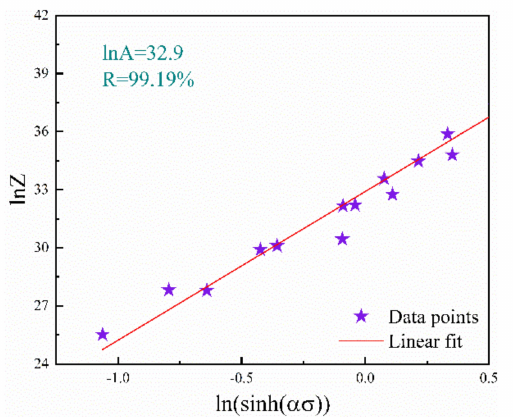
Figure 10. The relationship between flow stress and Z